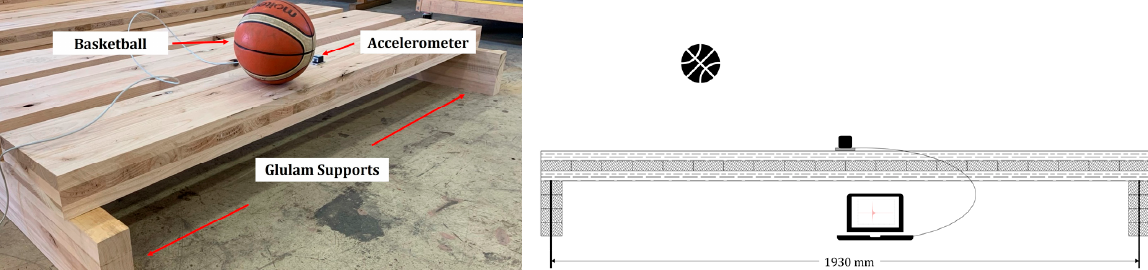
Figure 2. Setup of the vibration test.